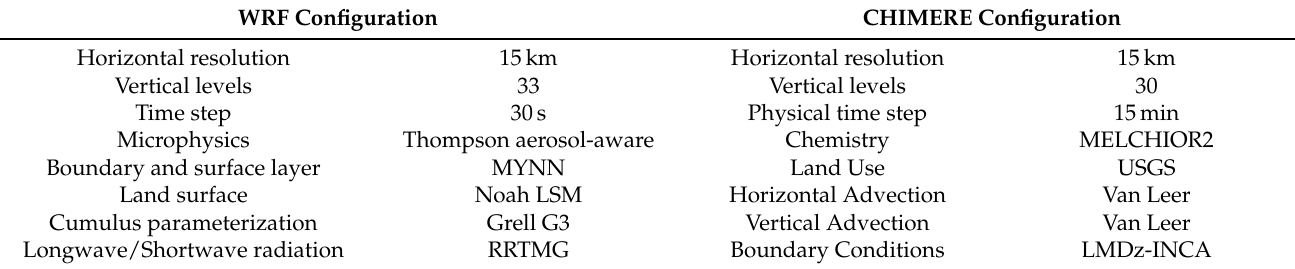
Table A1. WRF and CHIMERE